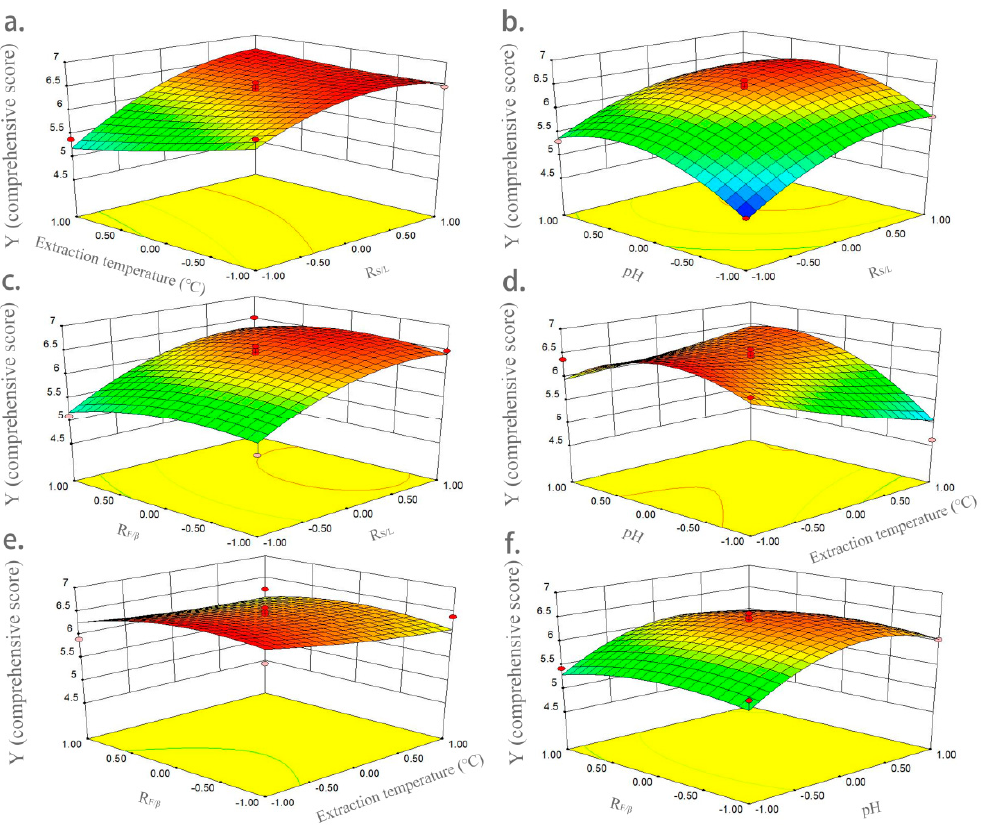
Figure 3. Three-dimensional response surface graphs of the influences of variables on comprehensive score. ( a ) Interaction of extraction temperature and R S/L ; ( b ) interaction of pH and R S/L ; ( c ) interaction of R F/ β and R S/L ; ( d ) interaction of pH and extraction temperature; ( e ) interaction of R F/ β and extraction temperature; and ( f ) interaction of R F/ β and pH.